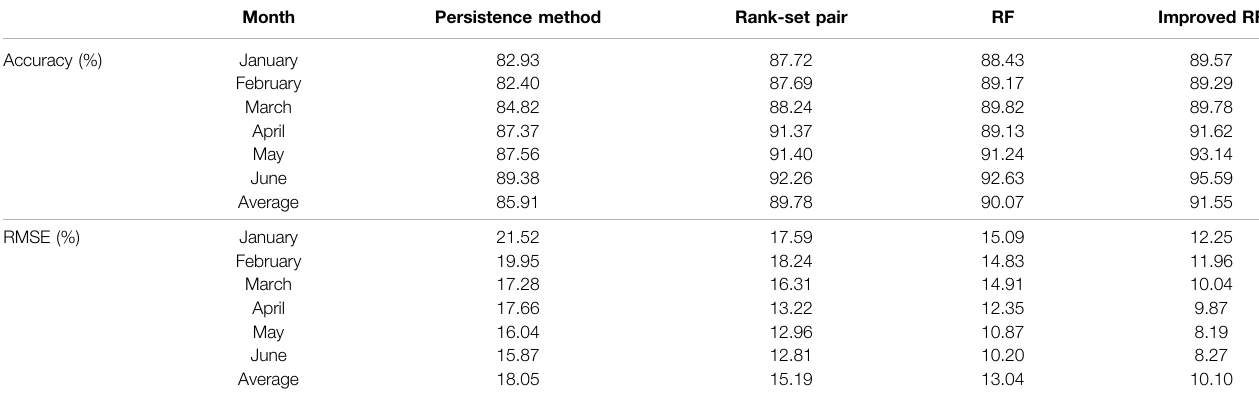
TABLE 5 | Comparison of results for each prediction method.